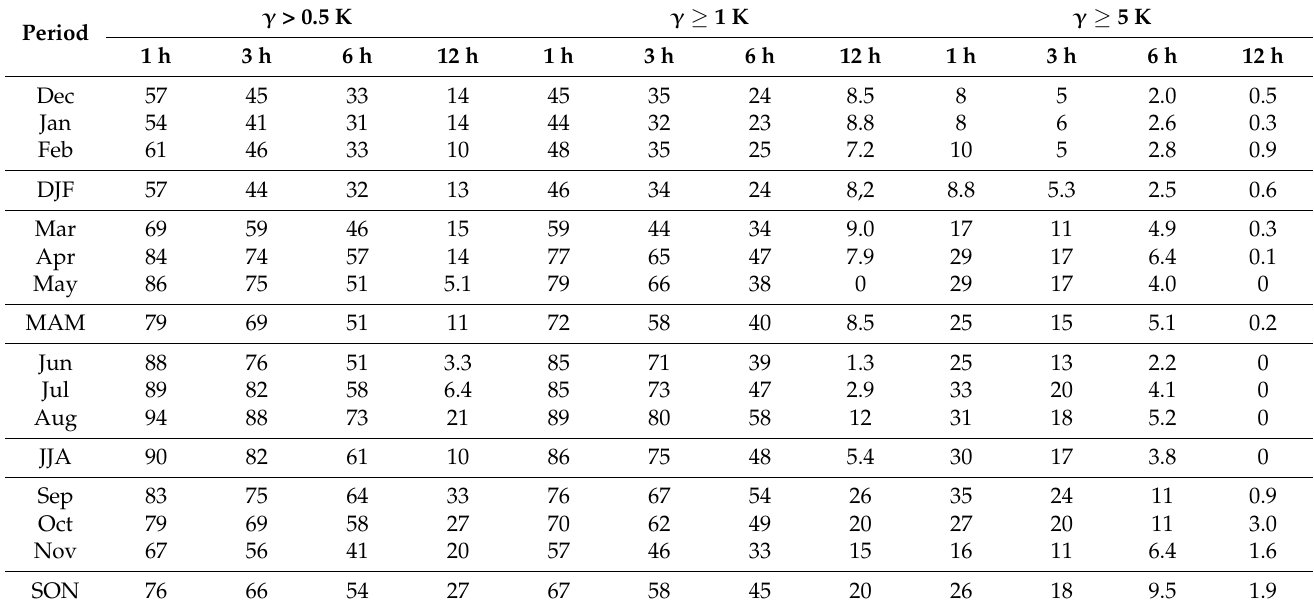
Table 3. Monthly and seasonal probability [%] of air temperature inversions of a duration of 1 h, 3 h, 6 h and 12 h calculated based on 1 h